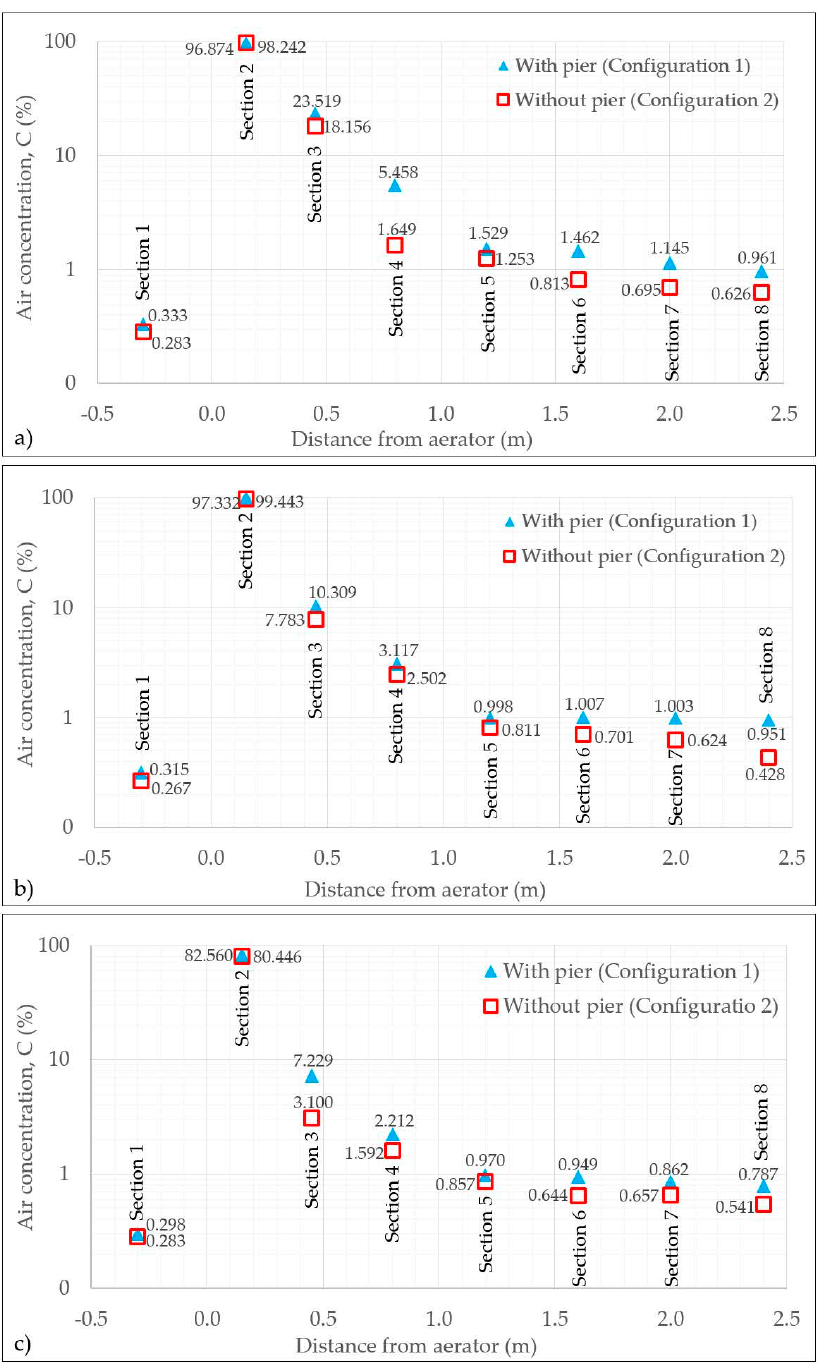
Figure 8. Longitudinal variations of air concentration at the spillway bottom for both model configurations: ( a ) 500 L/s, ( b ) 1000 L/s, ( c ) 1500 L/s. configurations: ( a ) 500 L/s, ( b ) 1000 L/s, ( c ) 1500